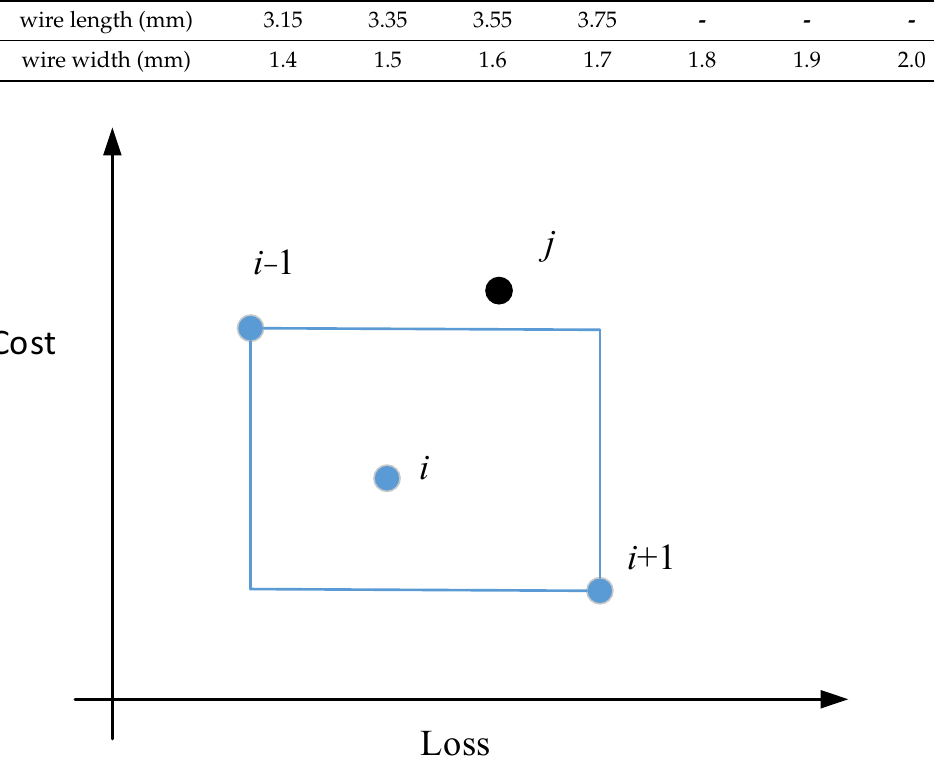
Figure 5. Schematic diagram of dominance relationships and crowding distance. (There is no dominance relationship between the blue dots. The black dot is dominated by the blue dot. The perimeter of the rectangle represents 2 times crowding distance of the i th individual)